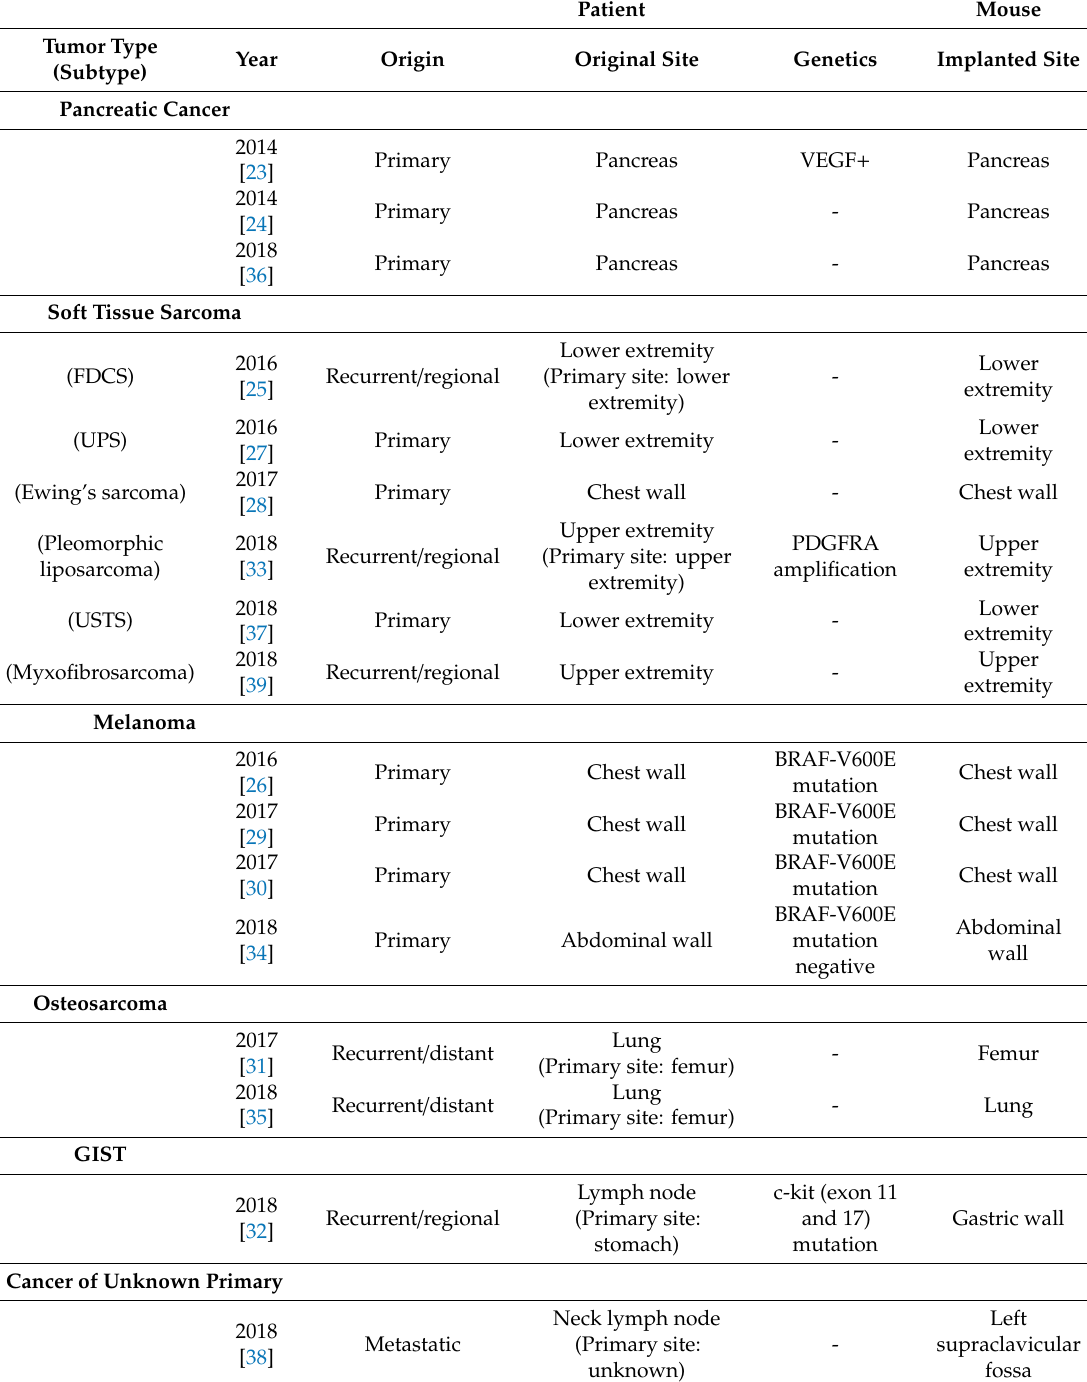
Table 1. Summary of studies in which S. typhimurium A1-R was administered to PDOX